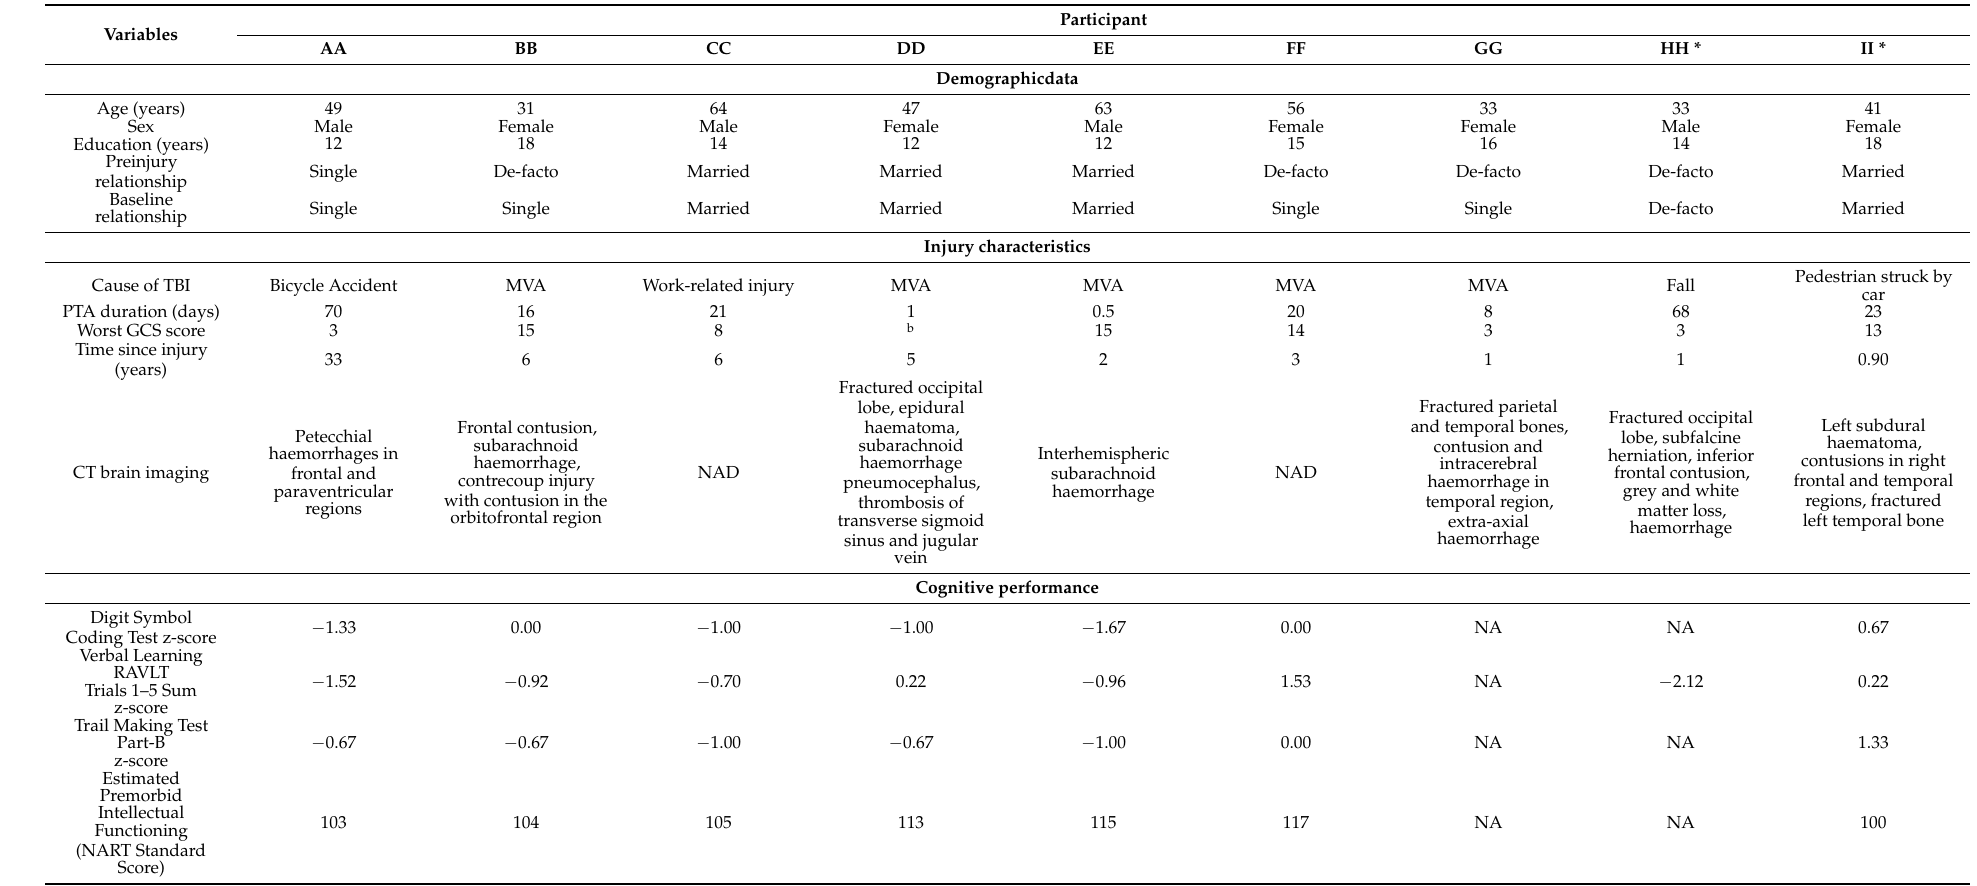
Table 1. Demographic, injury, and cognitive characteristics of the